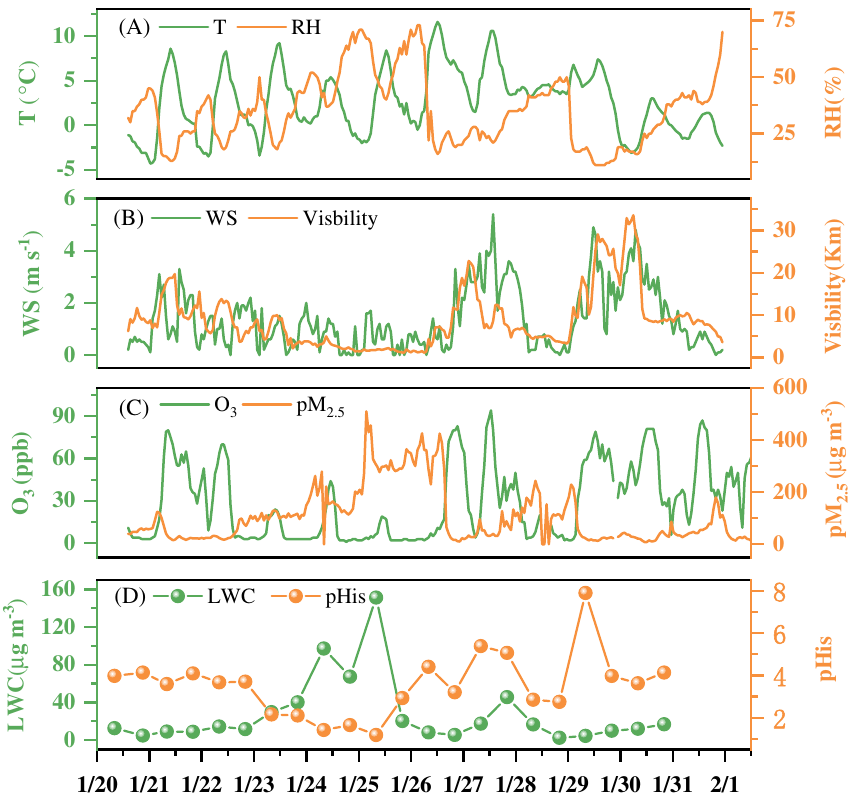
Figure 1. Diurnal variations of temperature (T), relative humidity (RH), wind speed (WS), visibility concentrations of O 3 , PM 2.5 , liquid water content (LWC) and